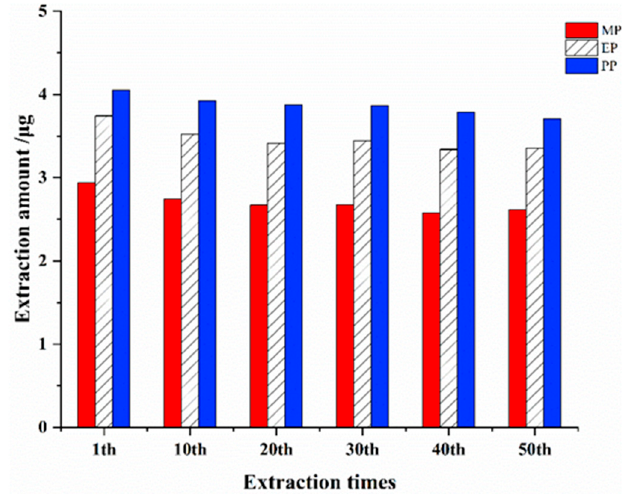
Figure 8. Evaluation of the service life of SMIP fiber array.